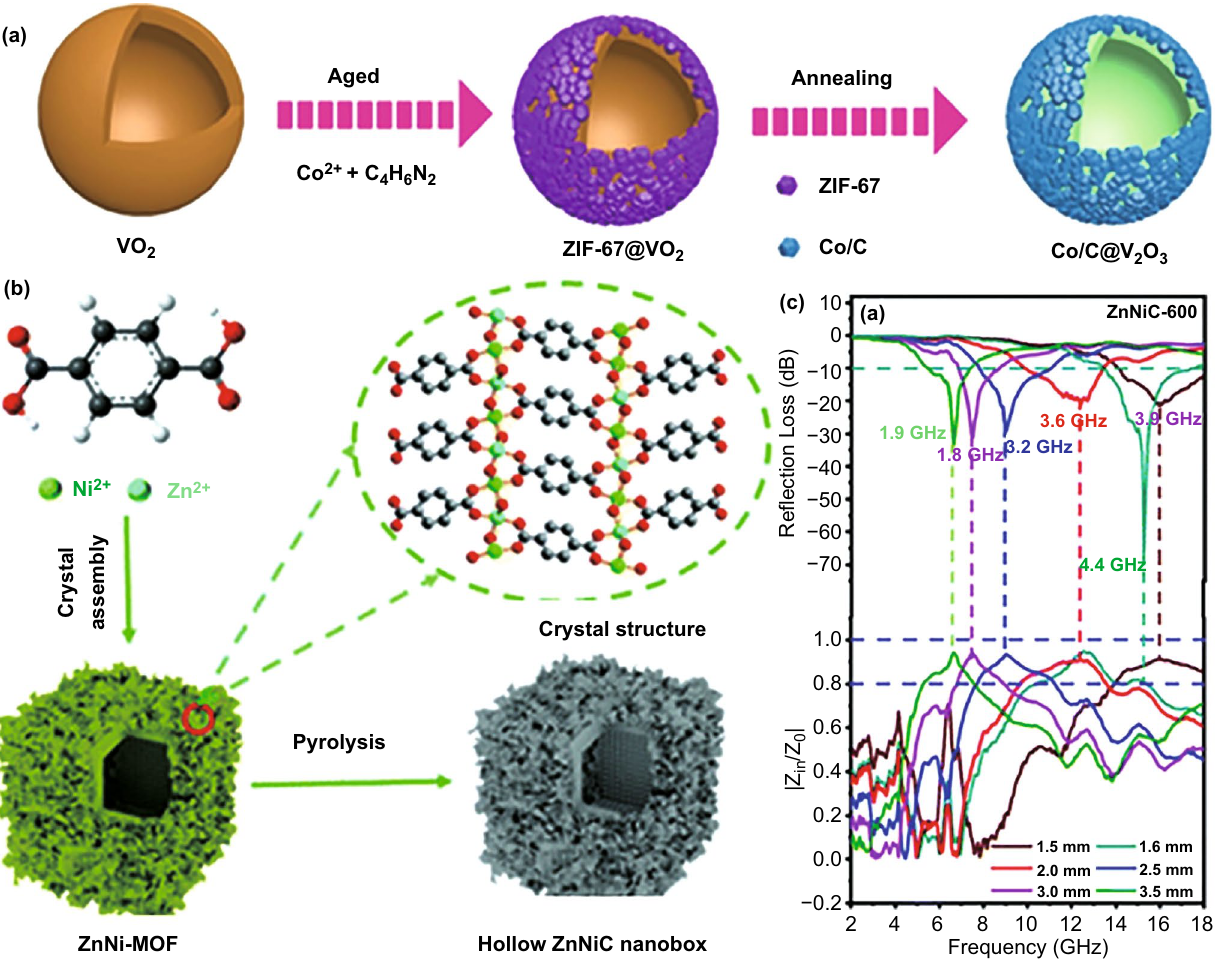
Fig. 9 a Synthesis process of hierarchical Co/C@V 2 O 3 hollow spheres. Reproduced with permission from Ref. [104] . Copyright © 2019 Wiley–VCH Verlag GmbH & Co. b Schematic illustration of hollow ZnNiC nano-box preparation , c RL curves and normalized input impedance of ZnNiC-600. Reproduced with permission from Ref. [142] . Copyright © 2020 The Royal Society of